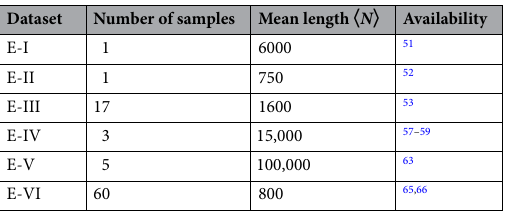
Table 3. Characteristics of empirical